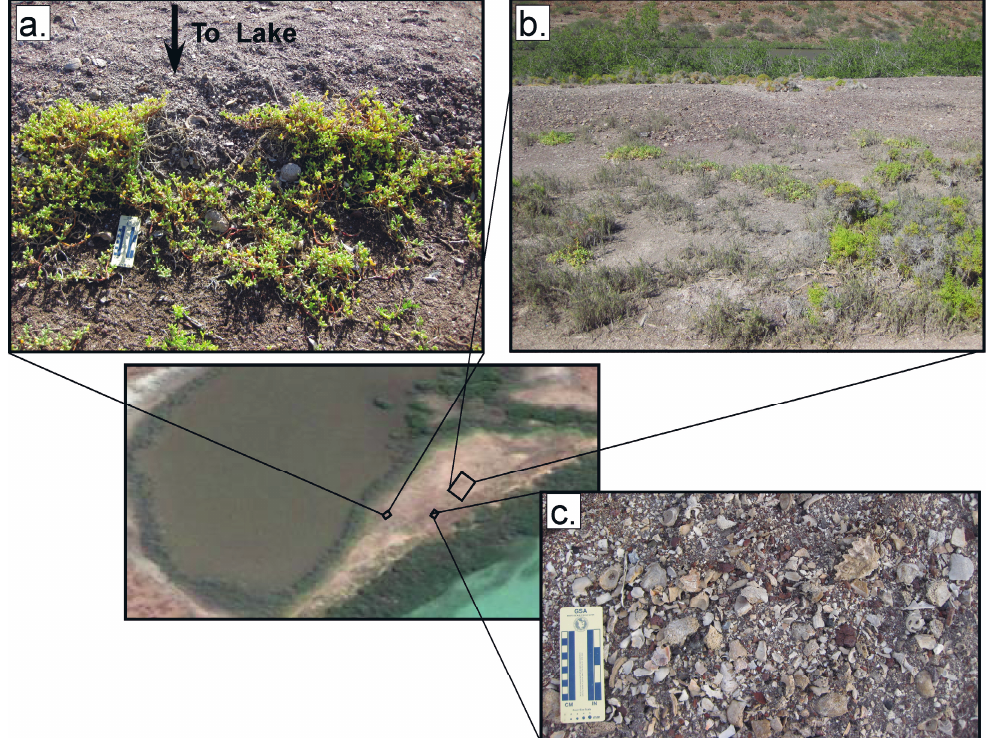
Figure 5. Area B. Area B consists of a wedge–shape deposit with a maximum thickness of ~50 cm, consisting of an extremely poorly-sorted mix of marine and terrestrial material. Size varies, although the largest boulders are absent. Clear cliff faces occur on both the seaward and landward